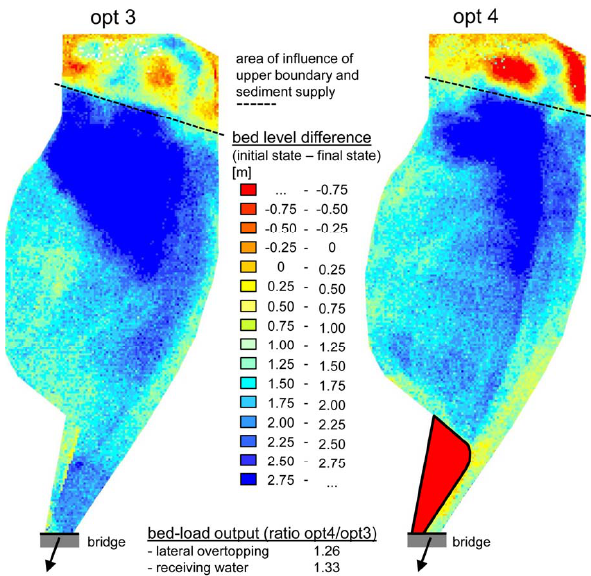
Fig. 8. Results from experimental modelling for the “opt 3” and “opt 4” design layouts (Fig. 4) – bed level changes in the deposition basin and relations of bed-load output both as lateral overtopping and entry into the receiving water course.